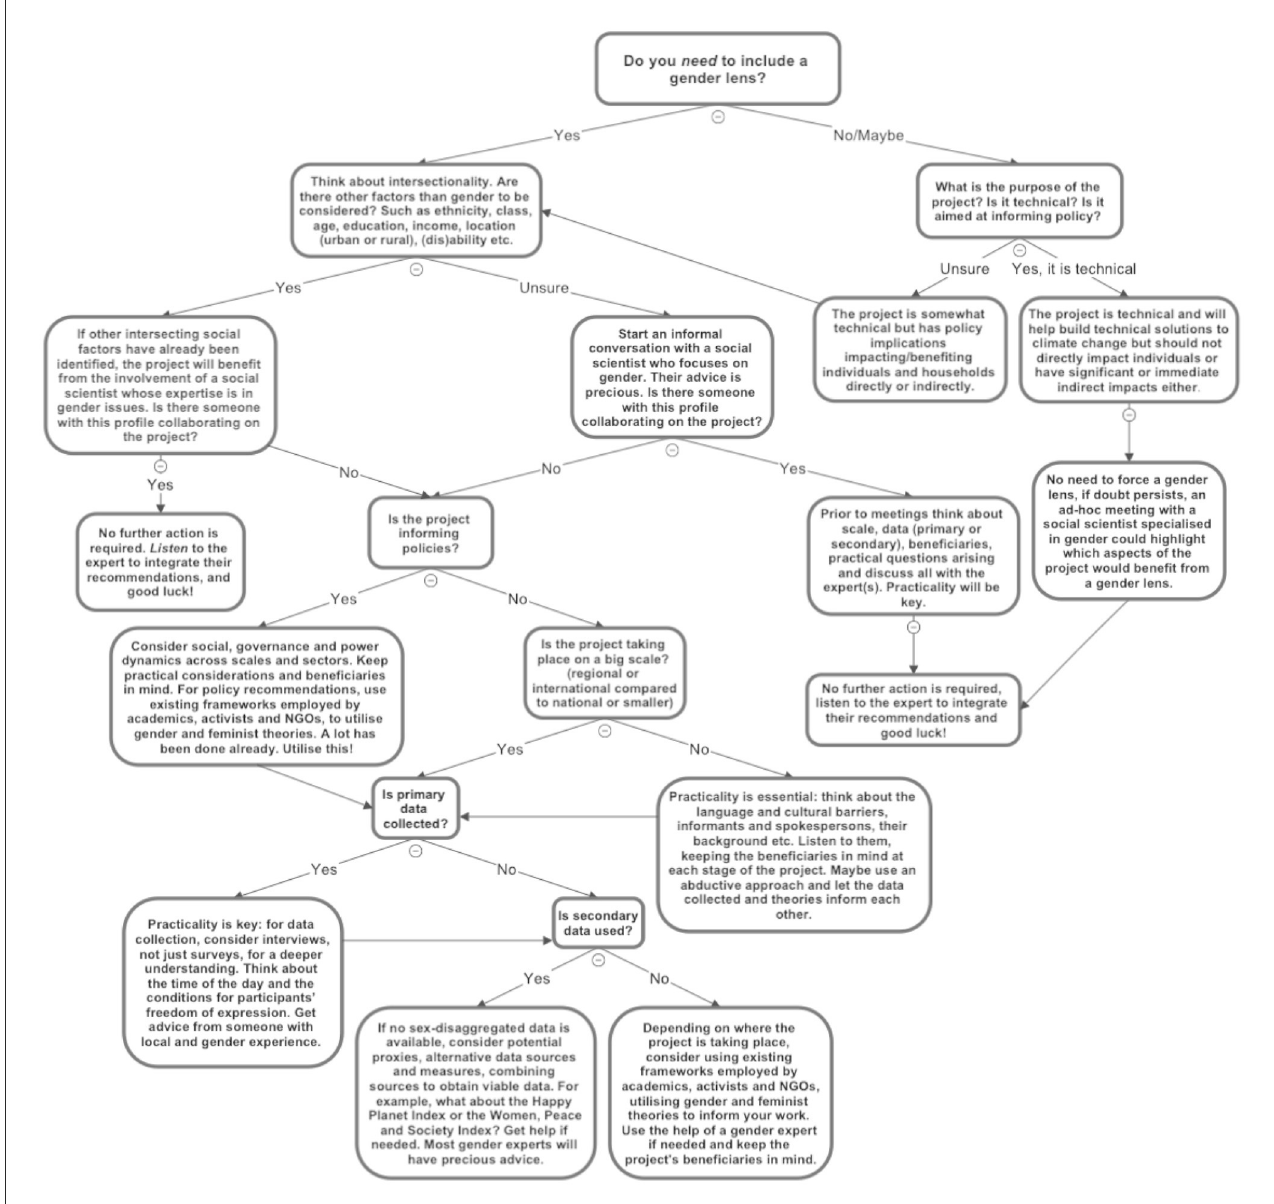
FIGURE5 Decision tree to inform environmental projects’ design seeking to integrate